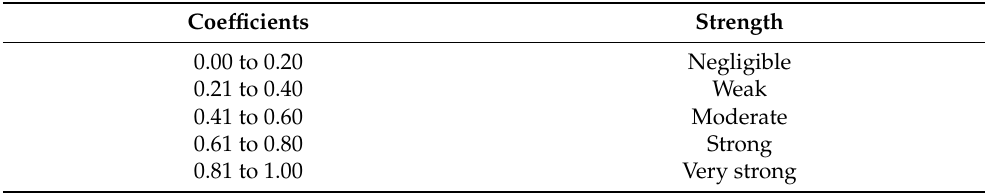
Table 1. Interpretation of Spearman rank-order correlation coefficients [53].